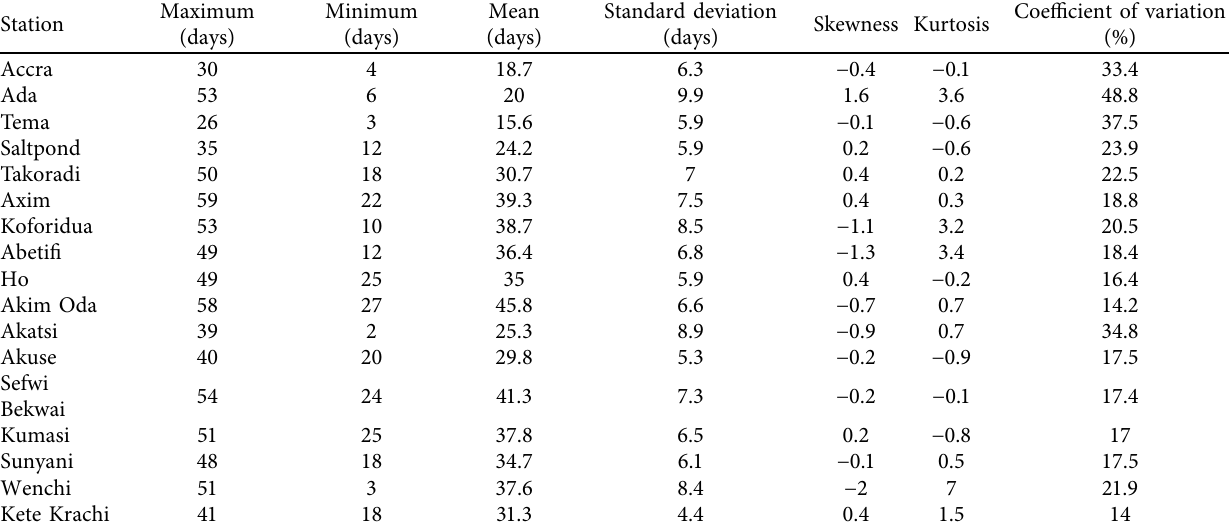
Table 3: Descriptive statistics for the minor season total frequency of rain in